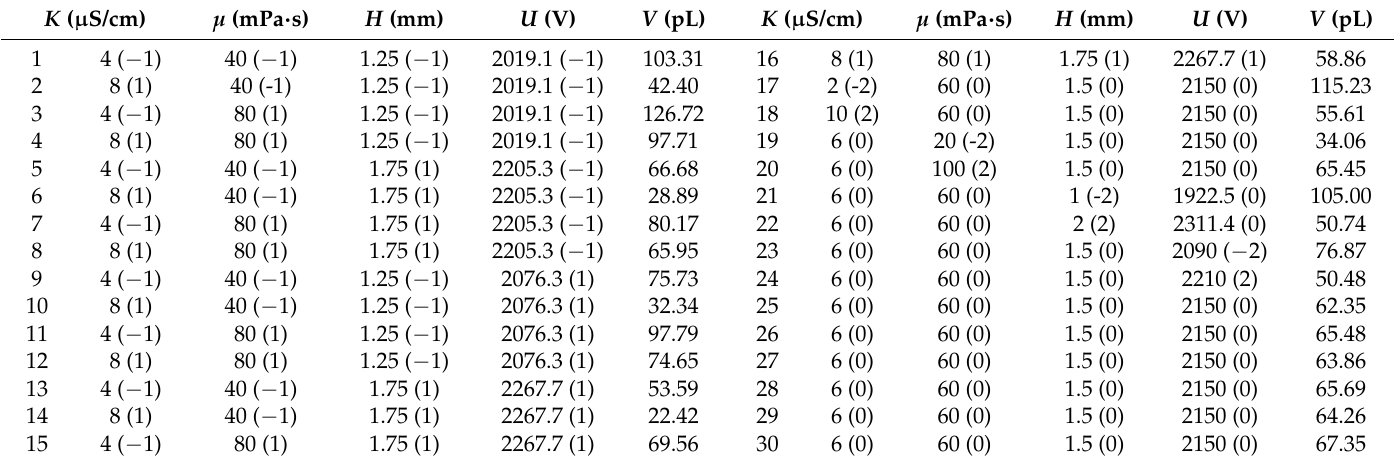
Table A2. The experiments and the experimental